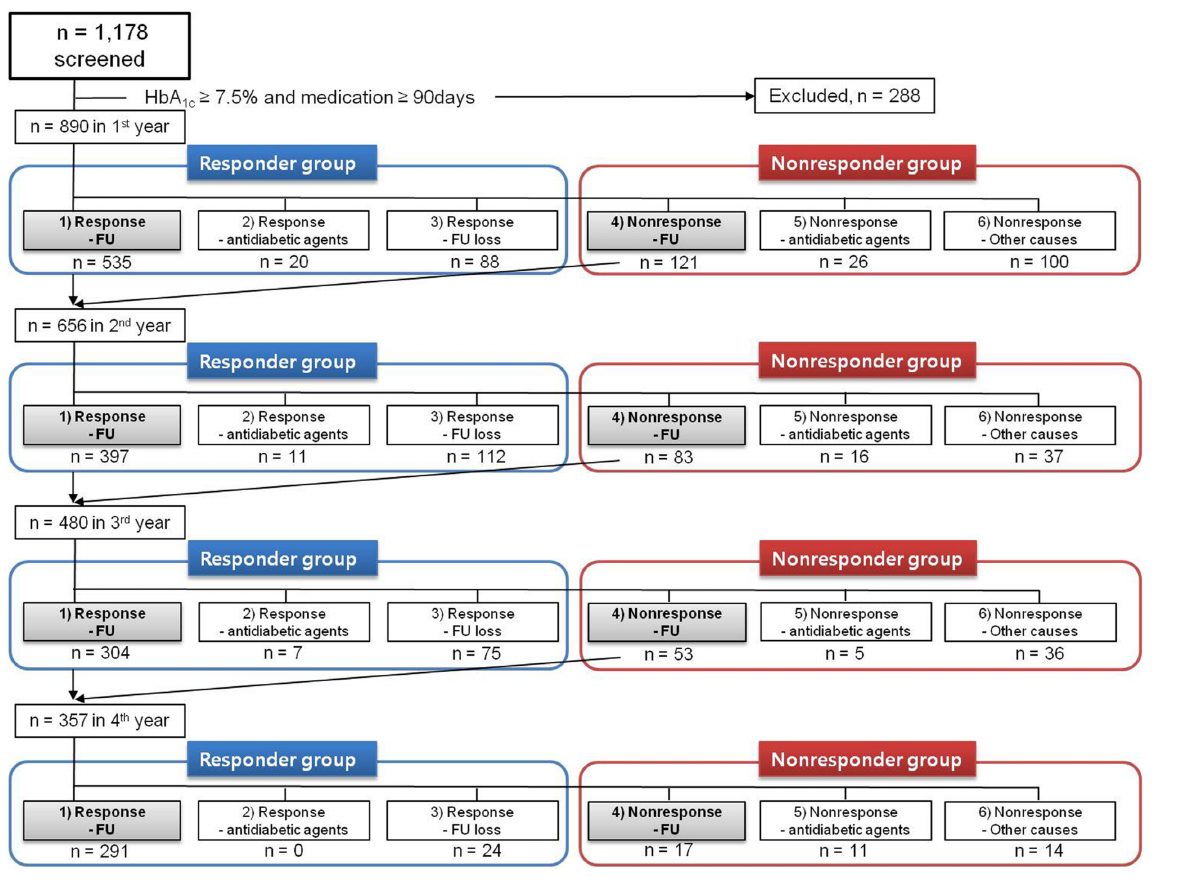
Fig 1. Study disposition. FU; follow-up.